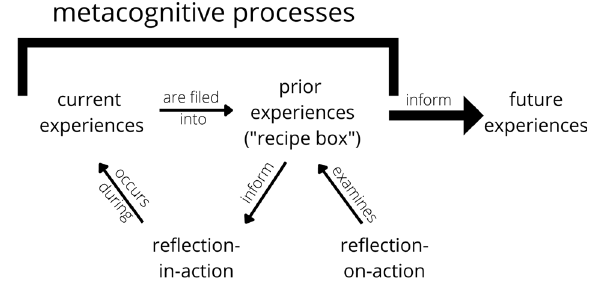
Fig. 2 Metacognitive processes that support learning from experience to inform future experiences. Re fl ection-on-action is experiential learning based on past experiences. Re fl ection-in-action is real-time re fl ection to link current experiences with relevant past